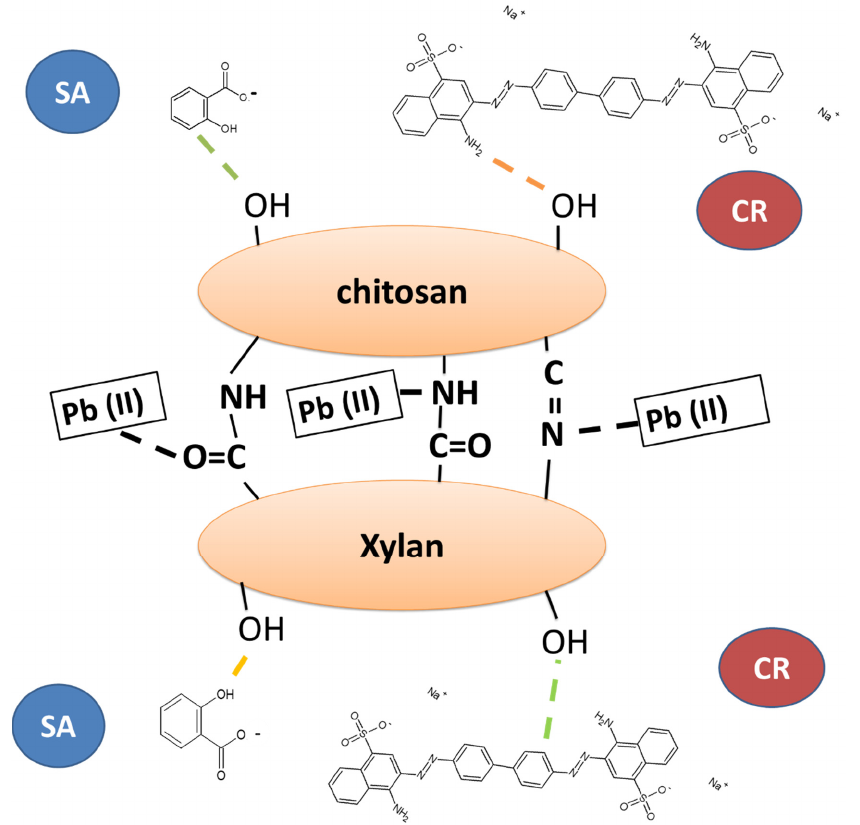
Figure 7. Some possible mechanisms of interaction for the adsorption of Pb(II), SA, and CR on CsXM, with black dotted line for chelation, orange dotted line for H-bonding, and green dotted line for van der Waals forces.